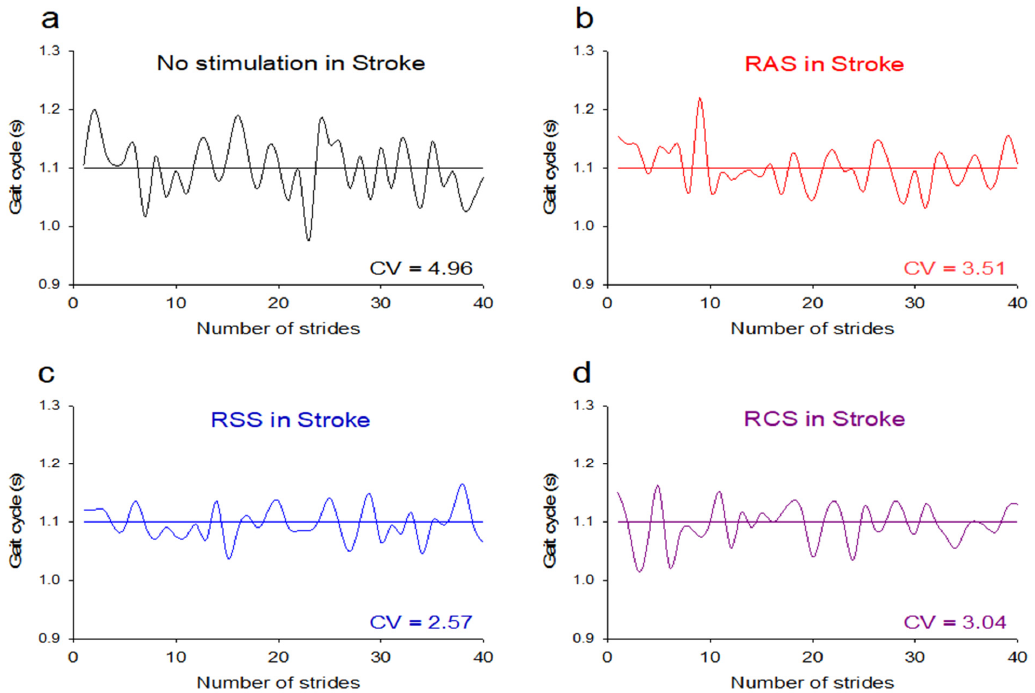
Figure 3. Examples of gait cycle from a patient with stroke in all walking conditions. ( a ) No stimu- lation: normal walking; ( b ) RAS: rhythmic auditory stimulation; ( c ) RSS: rhythmic somatosensory stimulation; ( d ) RCS: rhythmic combined stimulation (RAS + RSS). The horizontal lines are the average gait cycles of patients with stroke. CV: coefficient of